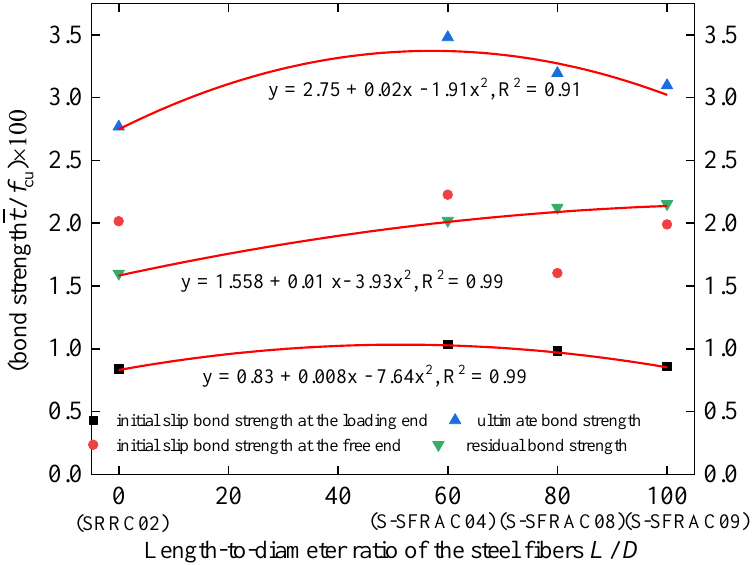
Figure 17. Relationship between bond strength and length-diameter ratio of the steel fiber.